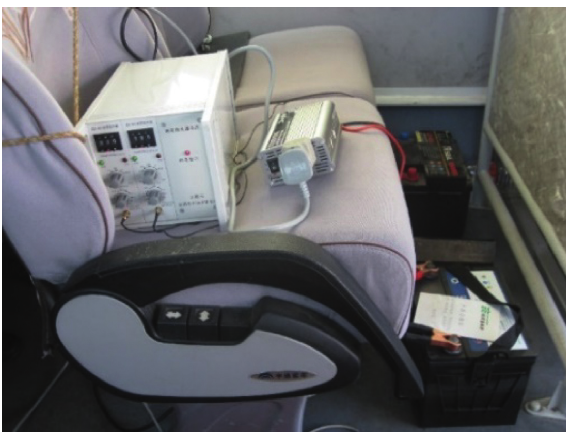
Figure 8: Inverter and battery connection.